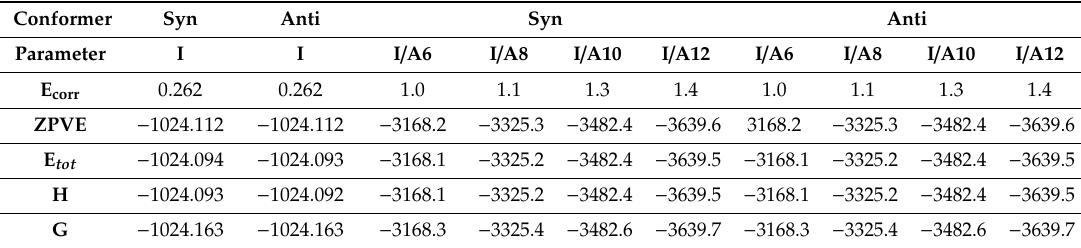
Table 1. Thermal parameters (Hartree / Particle) of both conformers of the base I as well as the H-bonded complexes I /